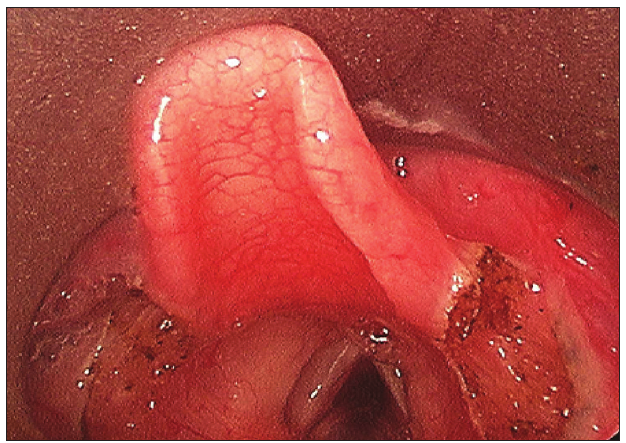
Figure 2. Post - aryepiglottoplasty with CO